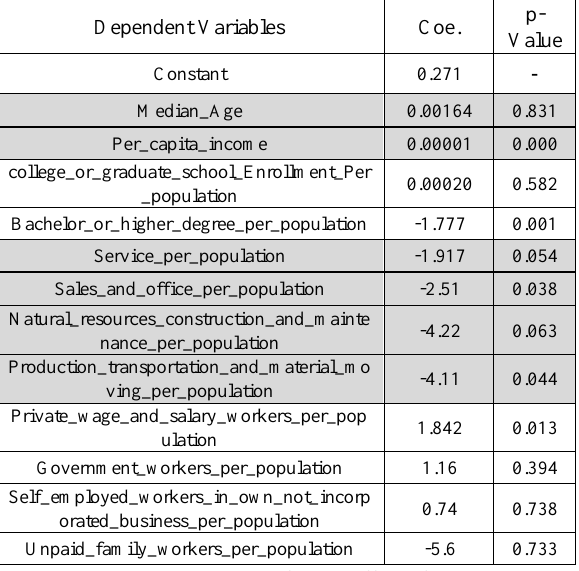
Table 1. Regression Results for the Effect of Socioeconomic Characteristics on the Number of